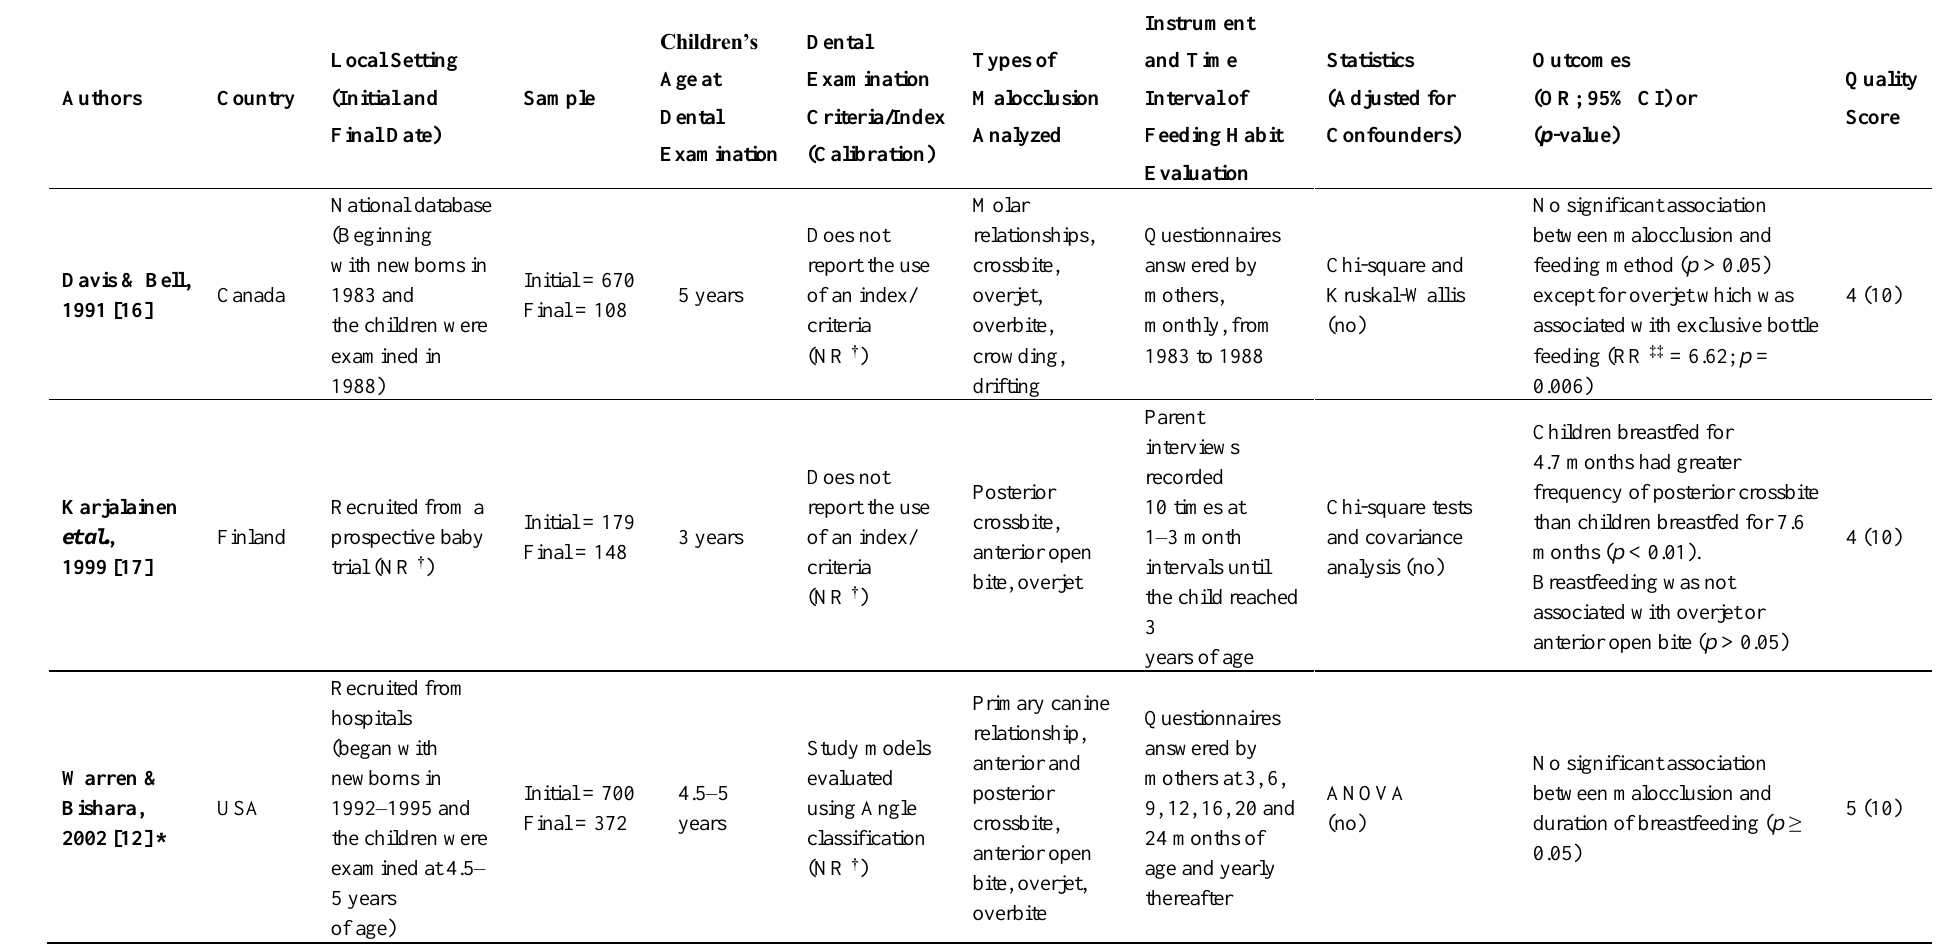
Table 2. Cohort studies included in the systematic review ordered according to quality